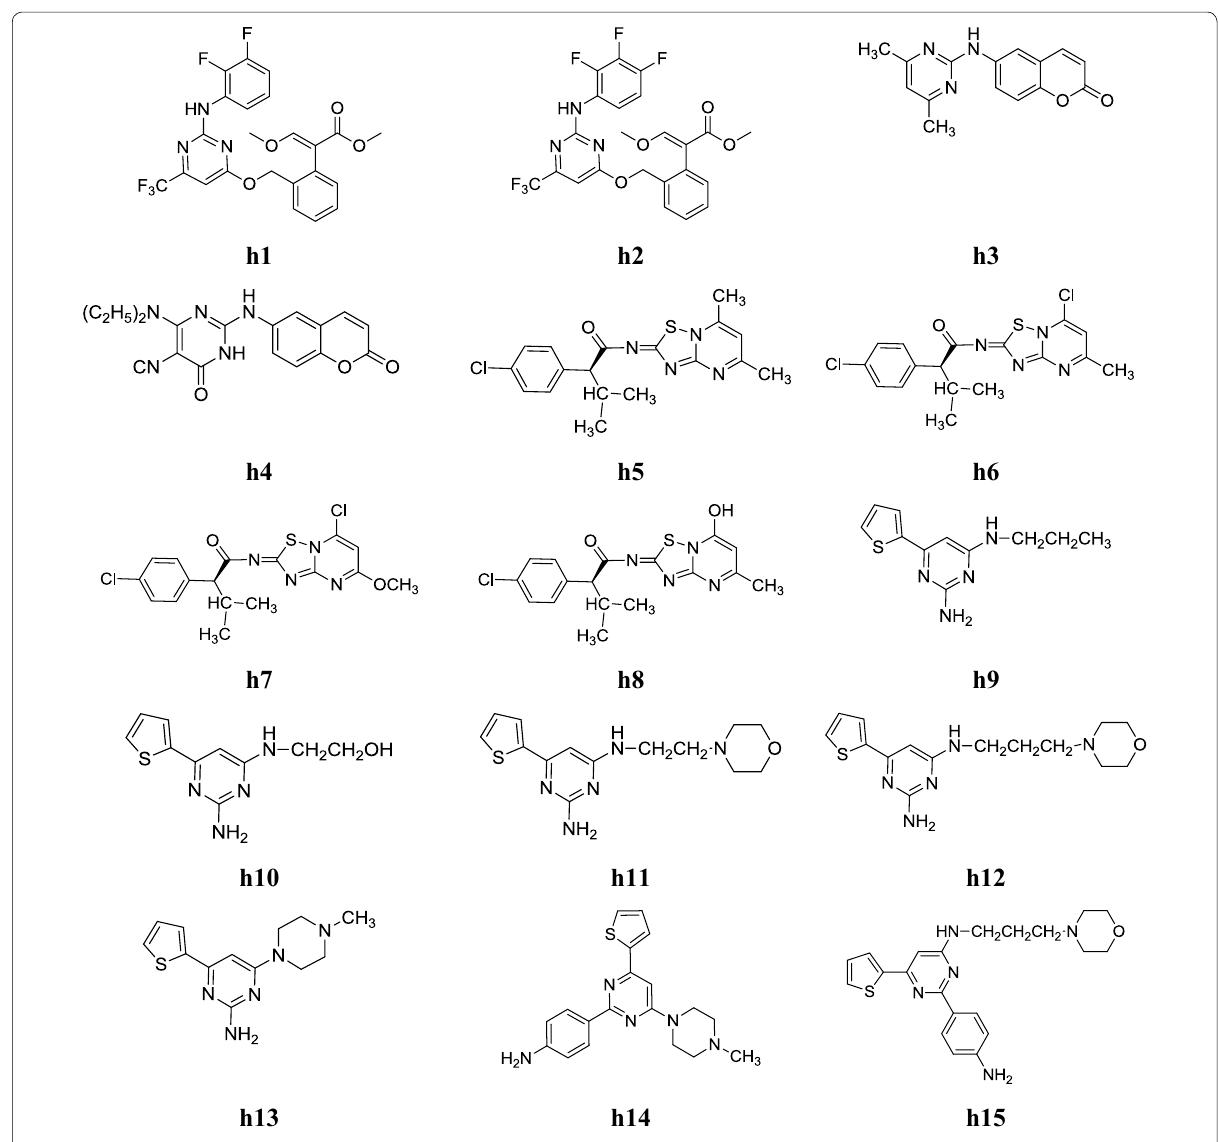
Fig. 14 Chemical structures of the most active pyrimidine derivatives ( h1 – h15 )